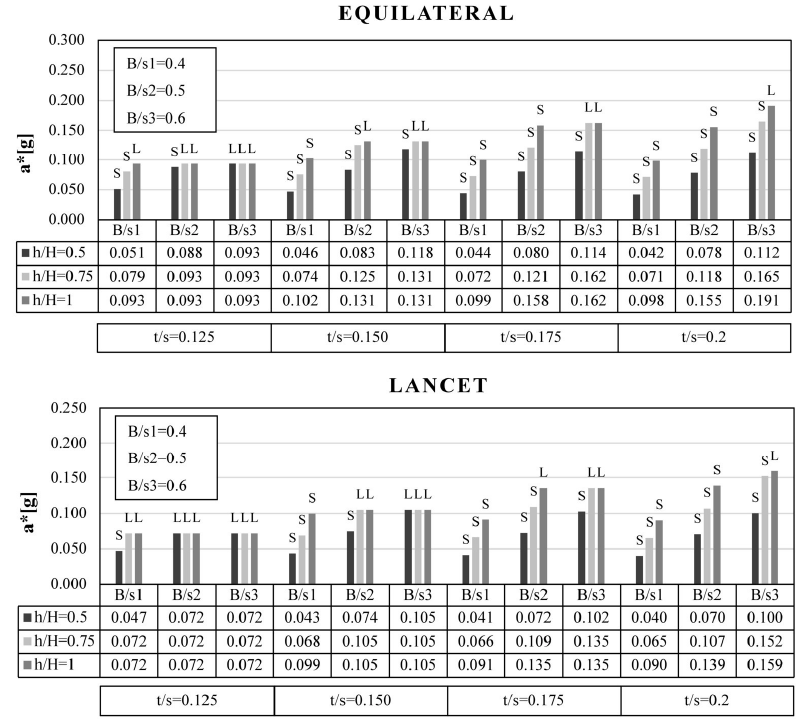
Figure 15. Values of a * for each considered eccentricity, t/s ratio, h/H configuration and B/s value. Local (L) or semi-global mechanism (S) are highlighted.